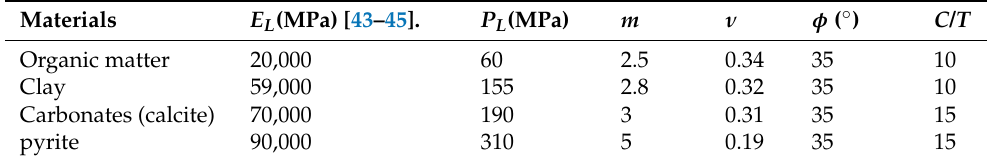
Table 1. Material properties of the shale FE